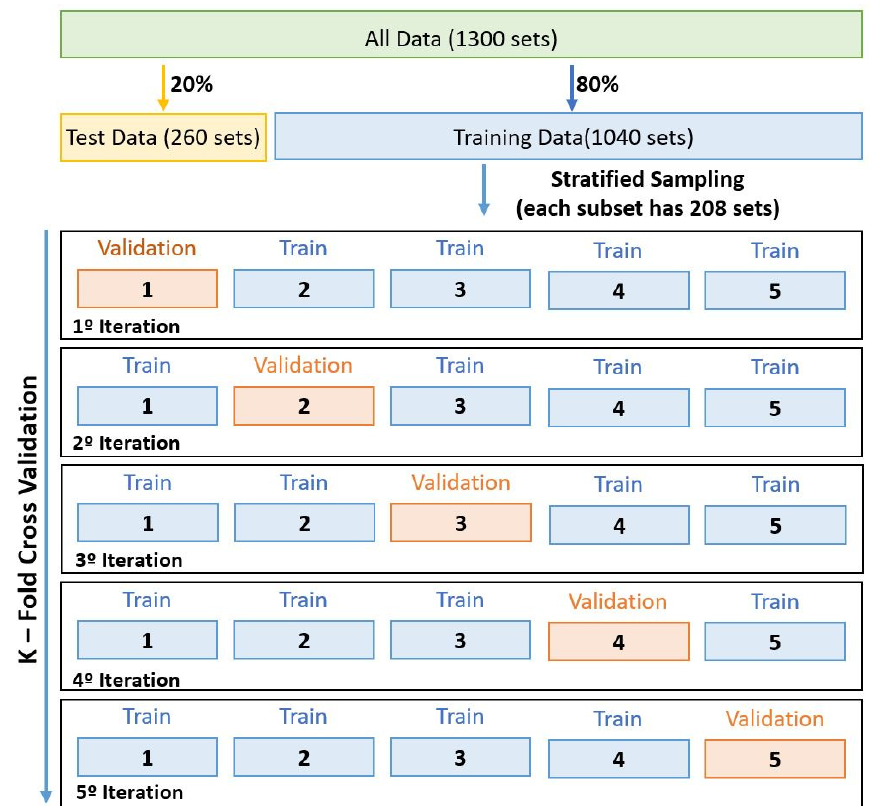
Figure 6. Accuracy of the training and validation data.